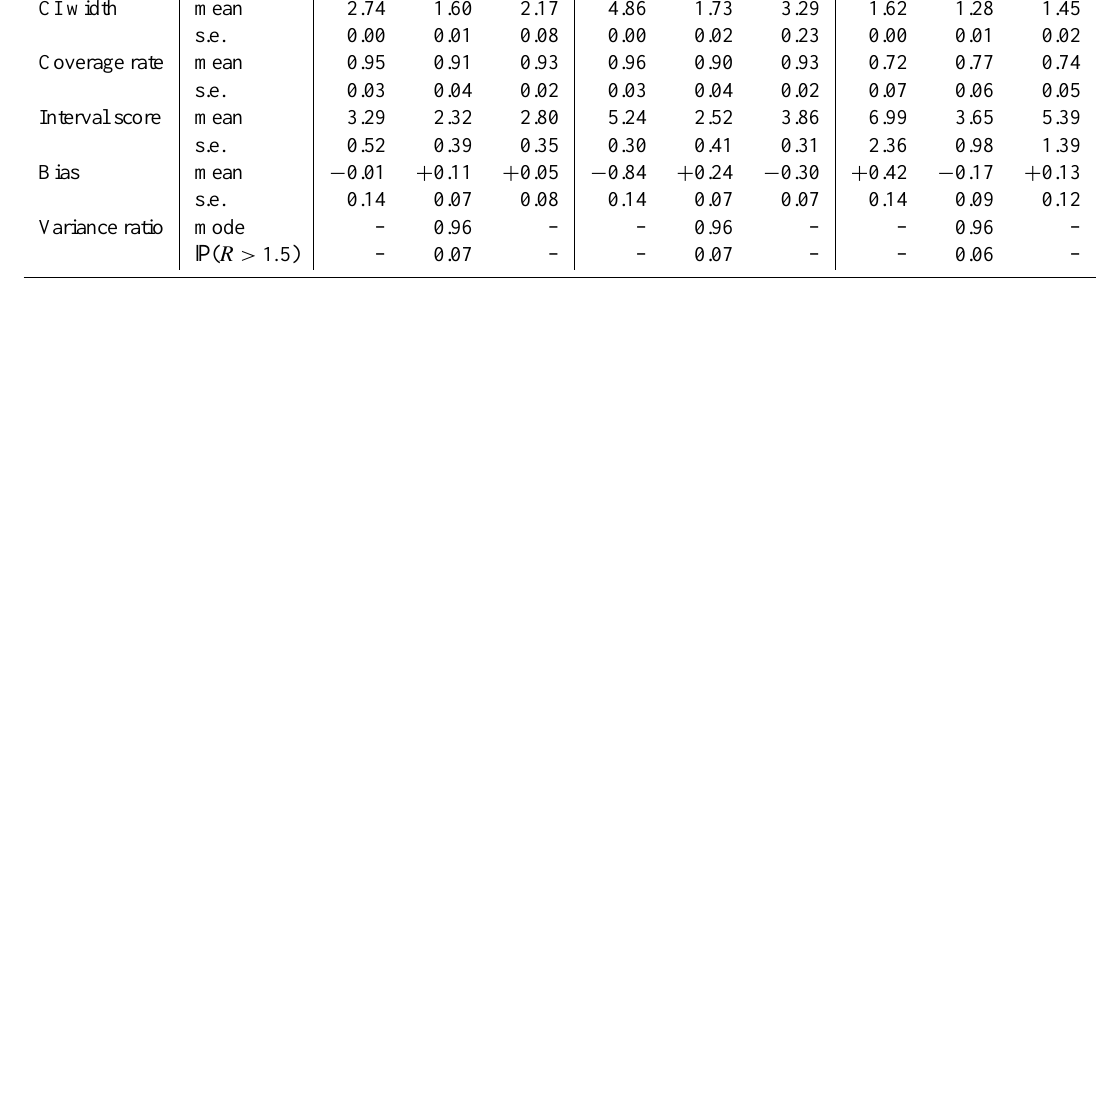
Table B1. Inference diagnostics derived from 1000 realizations of the climate process c ( t ), for three values of the prior standard deviation σ p , with δ = 0 . 5. CTL: σ p = σ (true standard deviation); DBL: σ p = 2 × σ ; HLF: σ p = 1